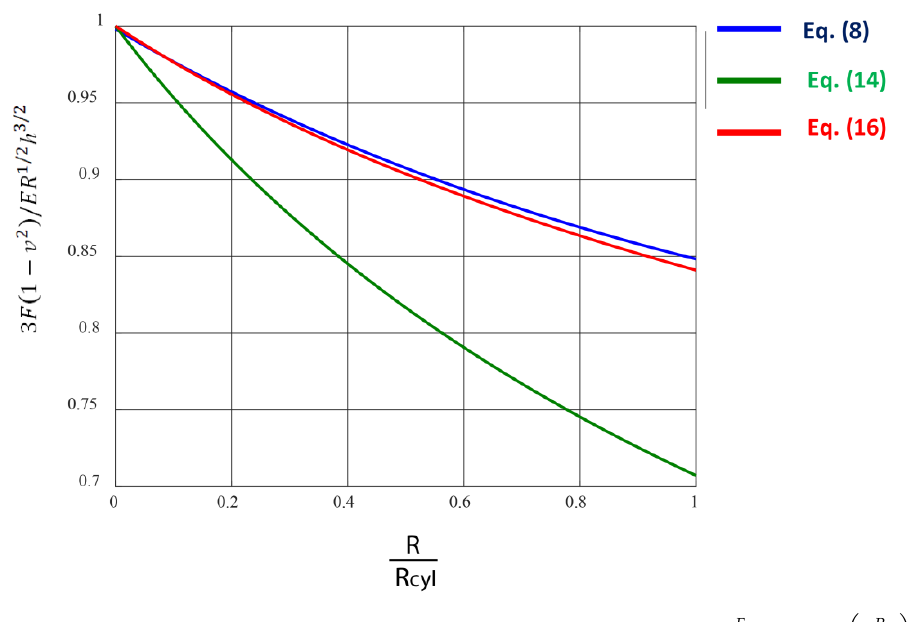
Figure 5. Plots representing different models for data processing. The F (cid:16) using different models. The accurate model regarding the sphere–cylinder interaction is provided by Equation (7).